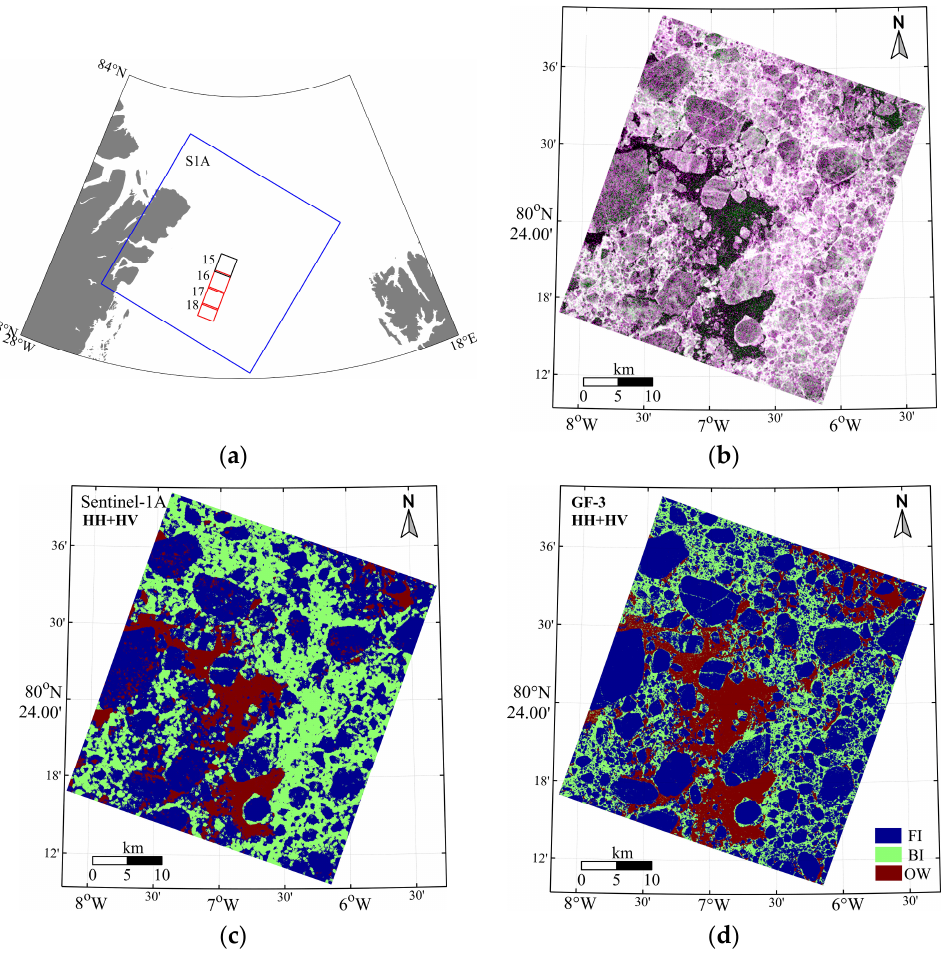
Figure 11. ( a ) Location of the near-coincident Sentinel-1A Extra Wide (EW) image mode data, with the GF-3 R3 scenes included. ( b ) The colocated and coincident S1A false-color image (with RGB represented by HH, HV, and HV channels, respectively) over the R3-15 scene. The sea ice classification results of the Sentinel-1A and GF-3 data are shown in ( c ) and ( d ), respectively. Table 5. Sea ice classification confusion matrix for the Sentinel-1A scene of the R3-15 scene and the GF-3 R3-15 scene based on MSI-ResNet.